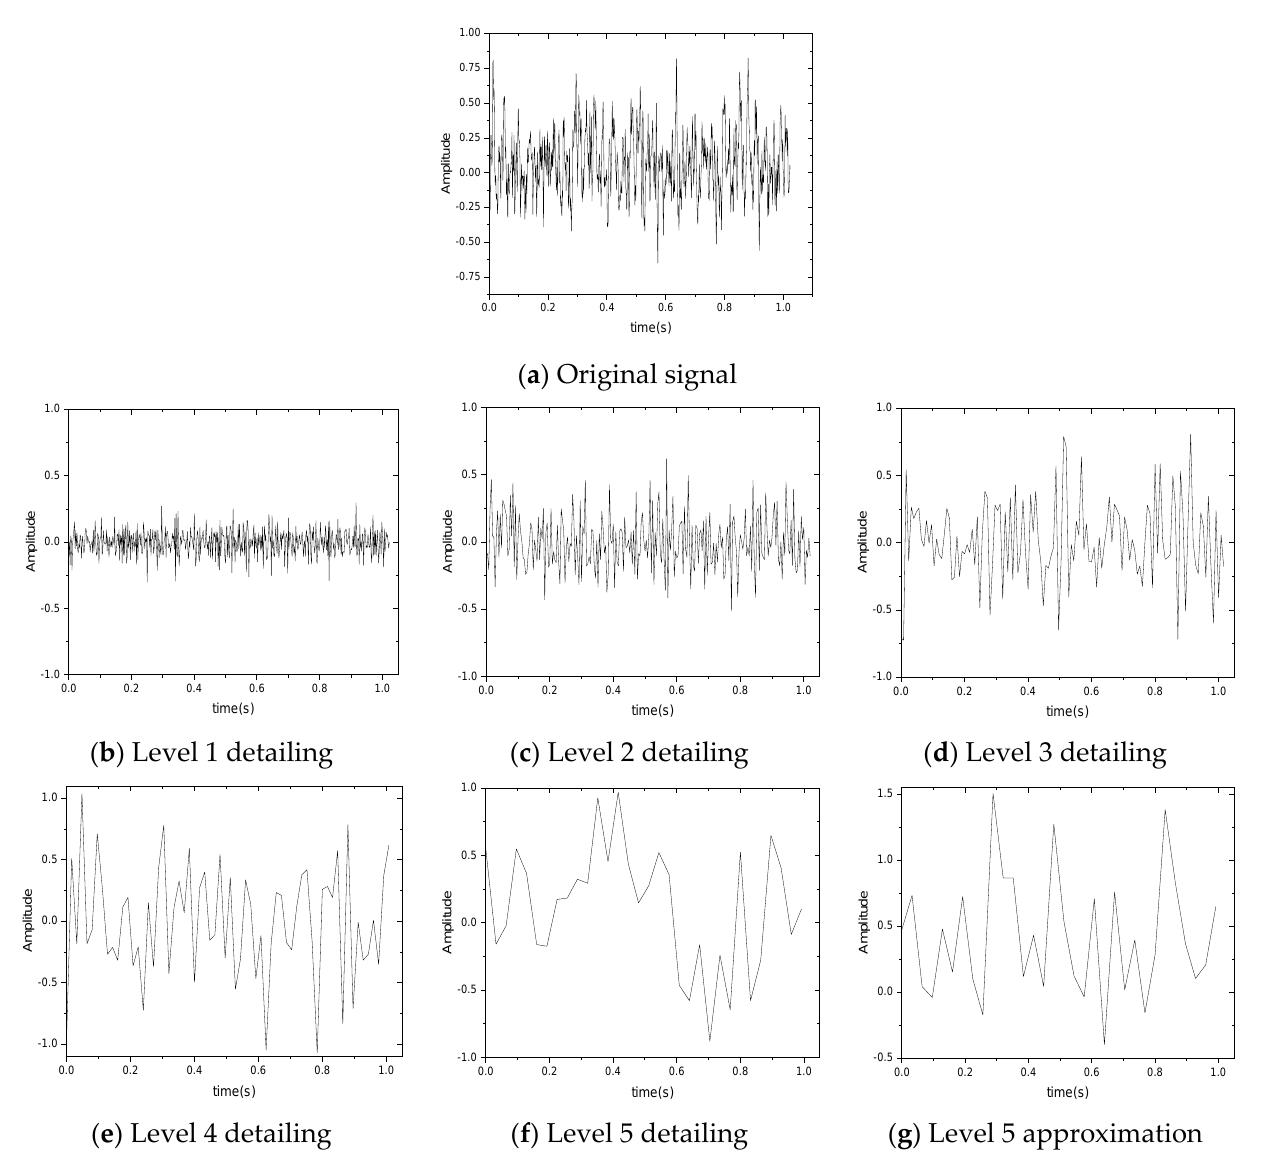
Figure 7. ( a ) Sensor vibration signal in one discrete sampling window. ( b – g ) Coefficients of the five-level approximation and detailing in wavelet decomposition.